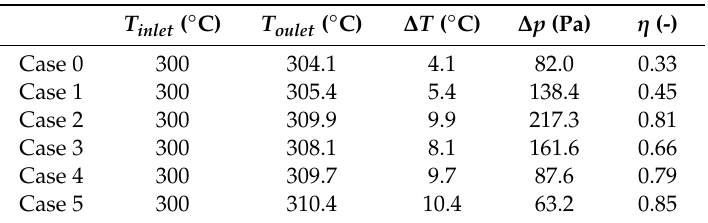
Table 2. Temperature increase, pressure drop, and heat removal e ffi ciency for evaluated designs of the proposed manifold header